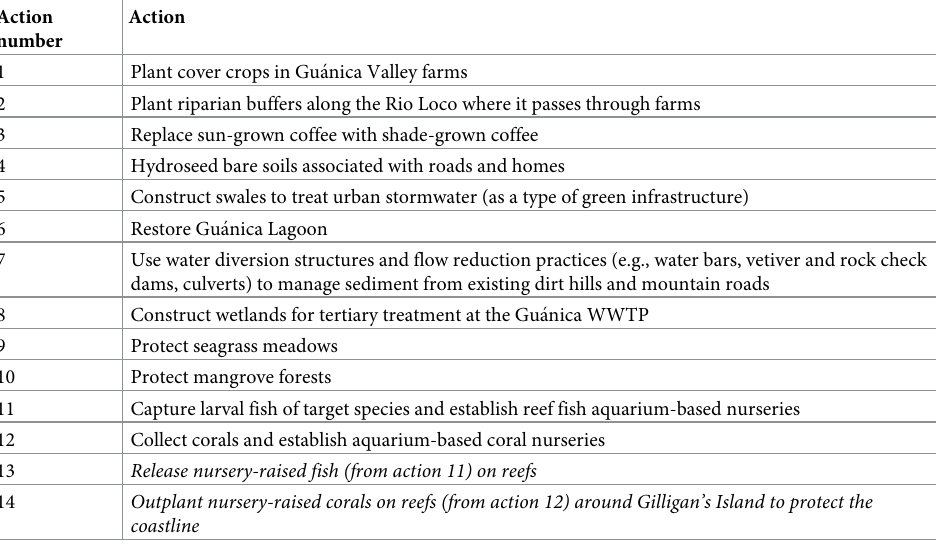
Table 1. The twelve first phase management actions and two actions (in italics ) that could not be addressed dur- ing the first phase because no reef resilience assessment had been